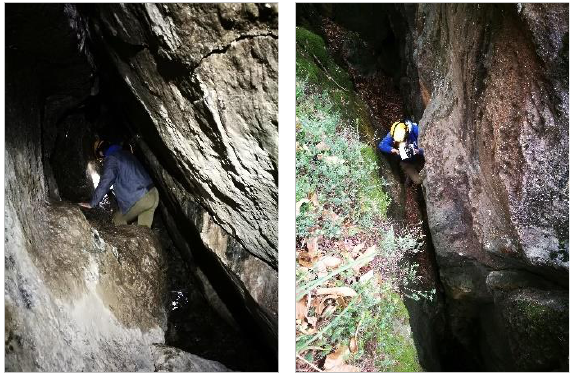
Figure 2 . “Trone” natural caves present along the path and surveyed.